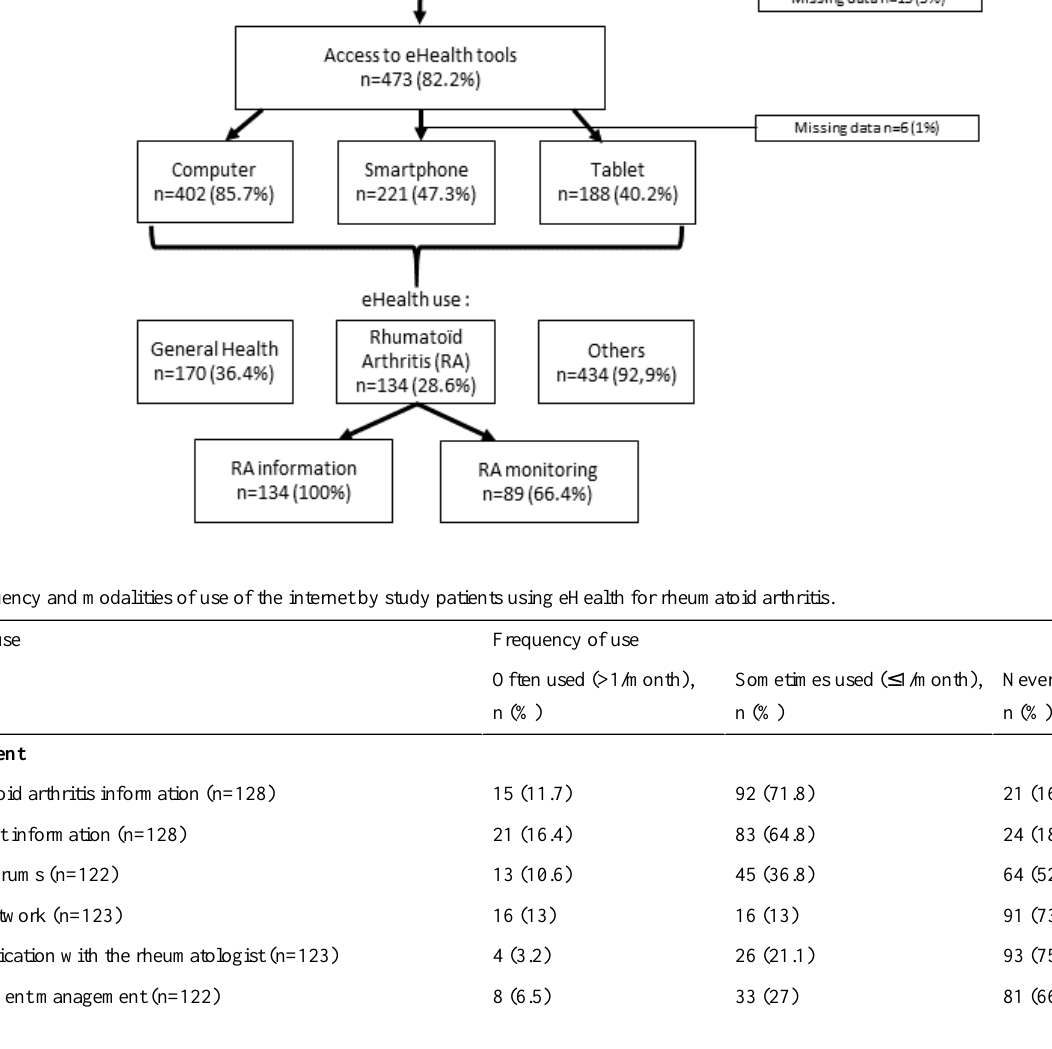
Figure 1. Use of eHealth tools in the study population.